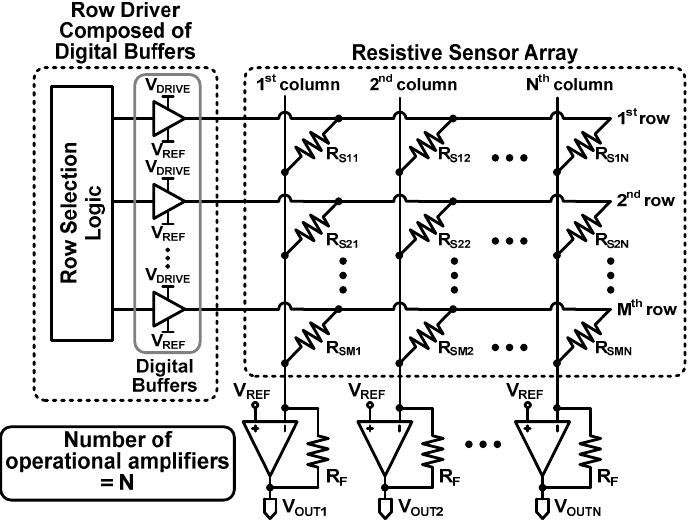
Figure 3. Zero-potential scanning method with a row driver composed of digital buffers (Type I).